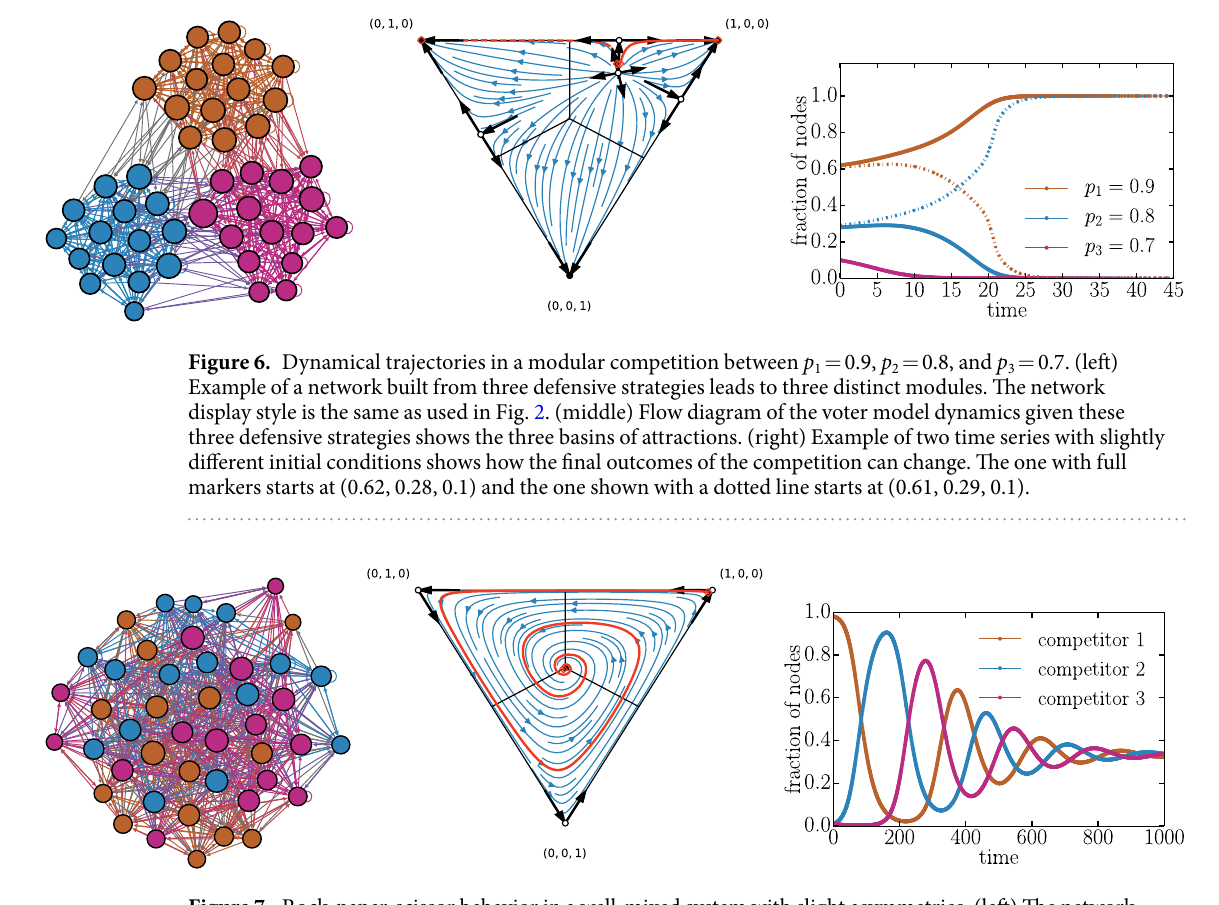
Figure 7. Rock-paper-scissor behavior in a well-mixed system with slight asymmetries. (left) The network architecture is well-mixed (i.e. an homogeneous network) as the asymmetries in density between groups are of the order of 1 in a 100 links. The network display style is the same as used in Fig. 2. (middle) The flow diagram resulting from the P matrix in Eq. (10) shows cyclic behavior. (right) The slight cyclical structure (1 targets 3, 2 targets 1 and 3 targets 2) is enough to give rise to damped cyclical behavior. Note that an asymmetry in the initial conditions is also needed. The stronger the asymmetries, the longer the oscillatory transient would